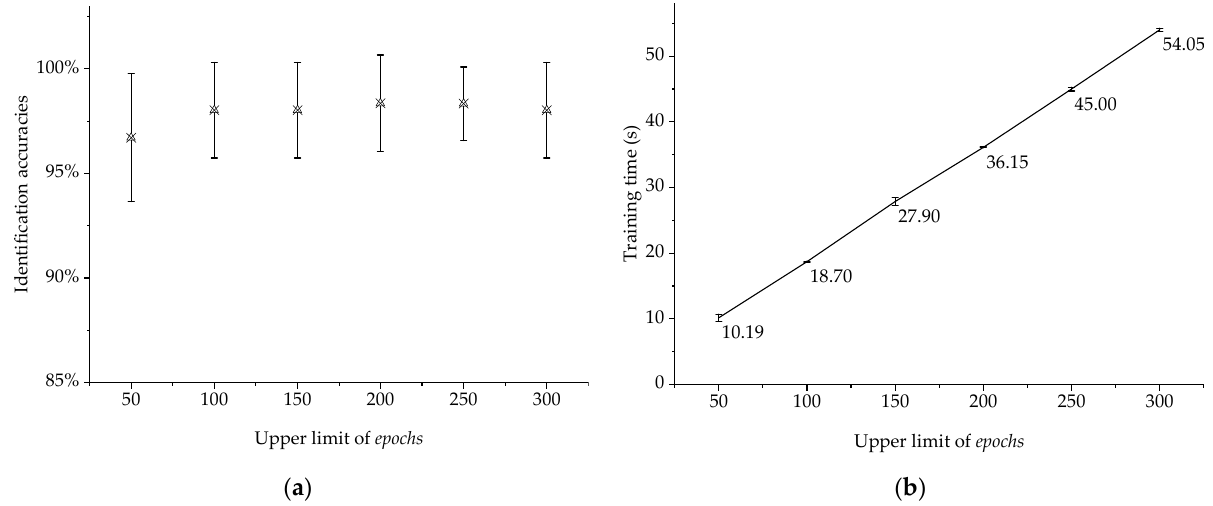
Figure 5. The error bars of the results obtained by training the LwCNN model for different numbers of epochs: ( a ) Error bars of the identification accuracies; ( b ) Error bars of the time spent for training a single LwCNN model.